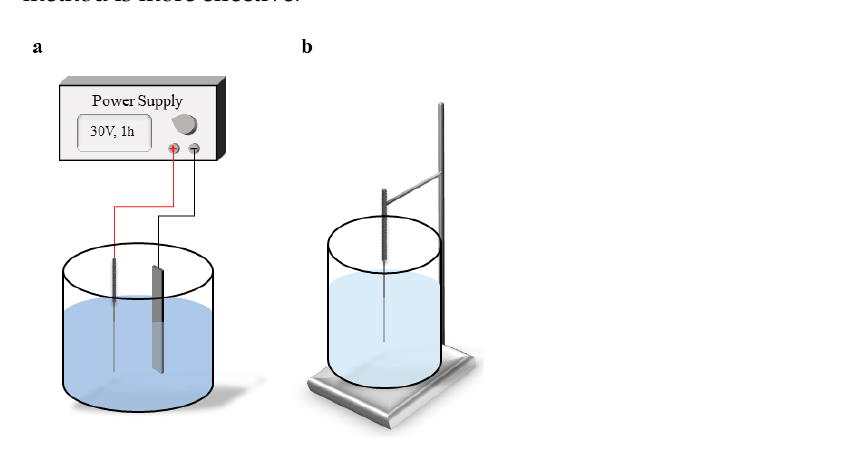
Figure 1. Schematic illustrations showing ( a ) electrochemical anodization setup used in preparing the PE and ( b ) hydrogen peroxide (H 2 O 2 ) immersion setup used in preparing the